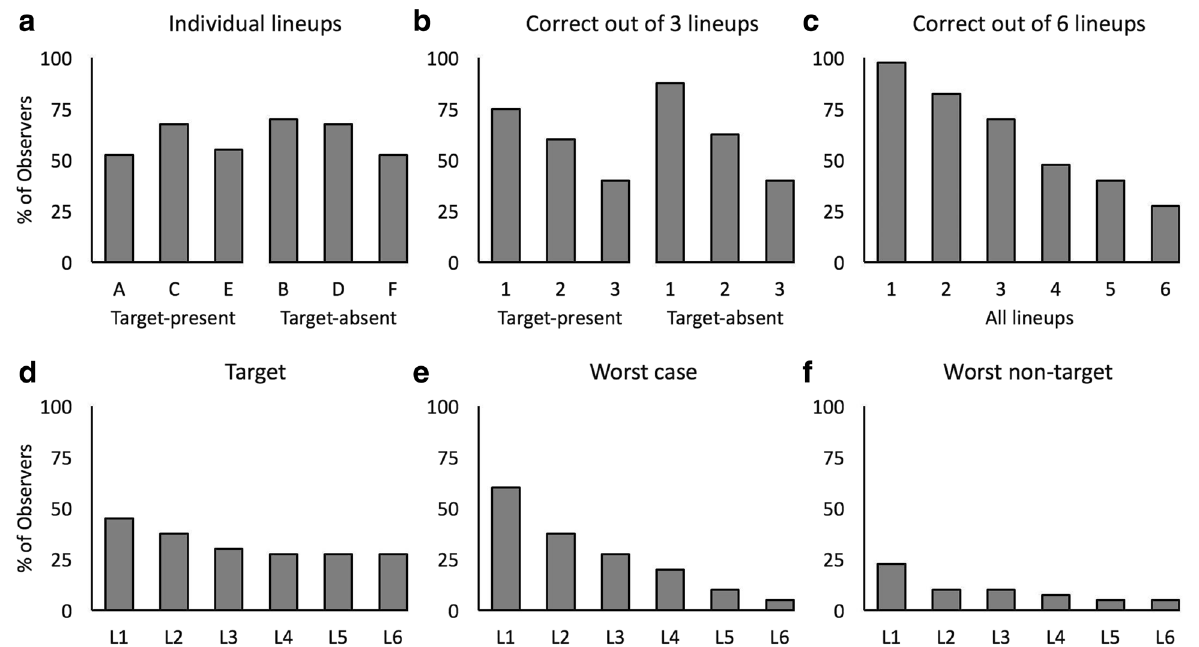
Fig. 2 Illustration of observers ’ responses in Experiment 1, showing hits for individual target-present and correct rejections for individual target-absent lineups ( a ), the number of hits and correct rejections out of three lineups ( b ), and the combined number of hits and correct rejections out of six lineups ( c ). In addition, observers ’ combined hits and correct rejections were analyzed by adhering to the order in which the six lineups were seen, for the target ( d ), the worst case analysis ( e ), and for the worst non-target ( f